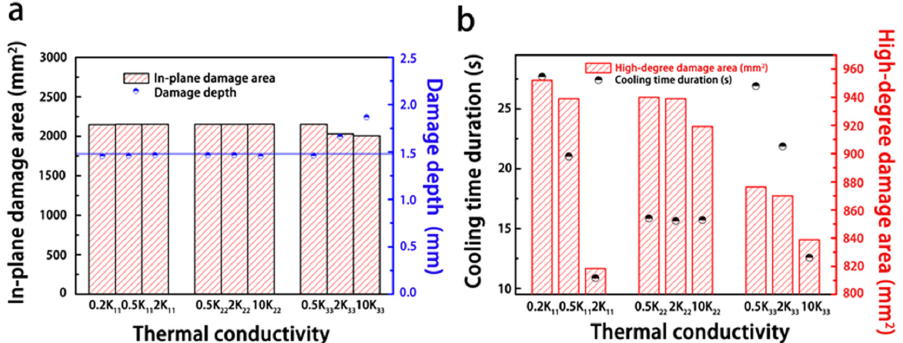
Figure 14. Influence of the thermal conductivity on the extent of the lightning damage: ( a ) variation in the degree of lightning damage with varying thermal conductivities ( b ) the relationship between the thermal conductivity, cooling duration, and size of the highly damaged area. The blue line represents the degree of damage in the original composite, and the number in front of thermal conductivity (K) indicates the increment multiple.